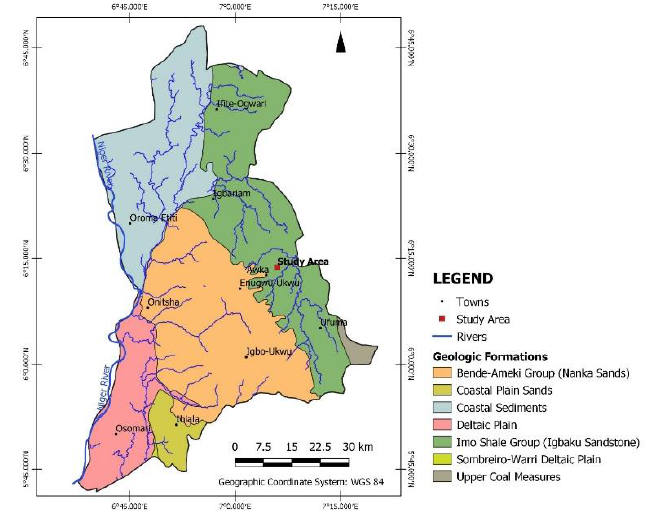
Figure 1: Geologic map of Anambra showing the study